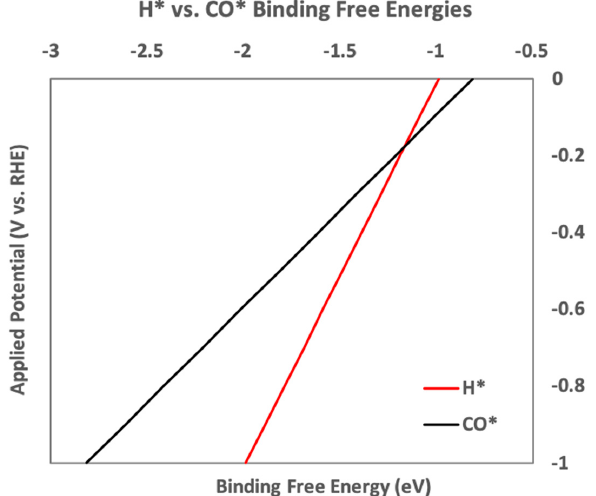
Figure 12. Comparison of adsorption/binding free energies of formation of H* and CO* on WC/Graphene catalyst system at various applied potentials ranging from 0 to 1 V vs. RHE. Red: H* binding free energies Black: CO* binding free energies.